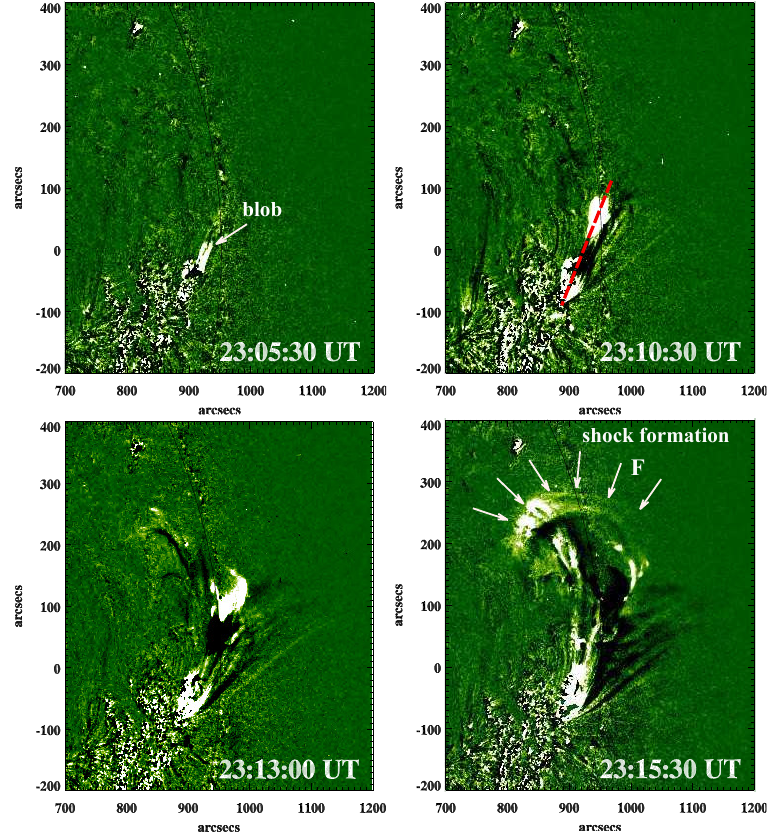
Figure 40: Eruption of a plasma blob and subsequent formation of an EUV wavefront, observed with STEREO/EUVI at 195 ˚A. Running difference images are shown (adapted from Kumar and Manoharan,